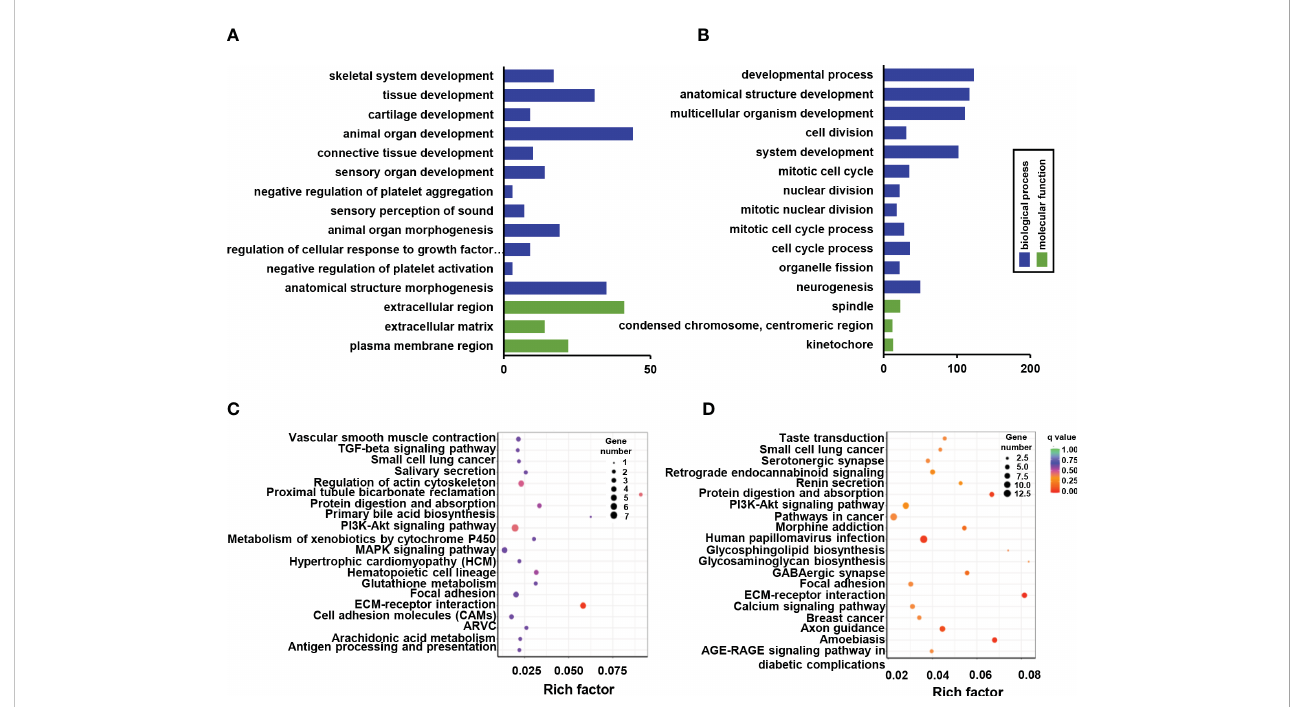
FIGURE 4 GO and KEGG pathway enrichment of DEGs between Ano5 +/+ and Ano5 KI/KI groups. (A, B) GO enrichment analysis of down-regulated DEGs (A) and up-